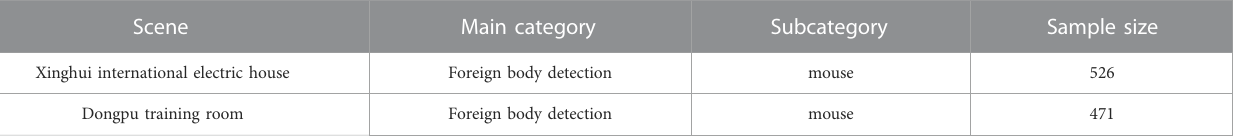
TABLE 1 Labeling of foreign bodies in the power distribution room.